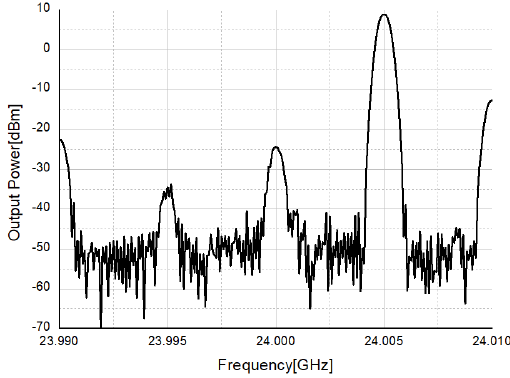
Figure 44. Transmitter output power measurement in CW